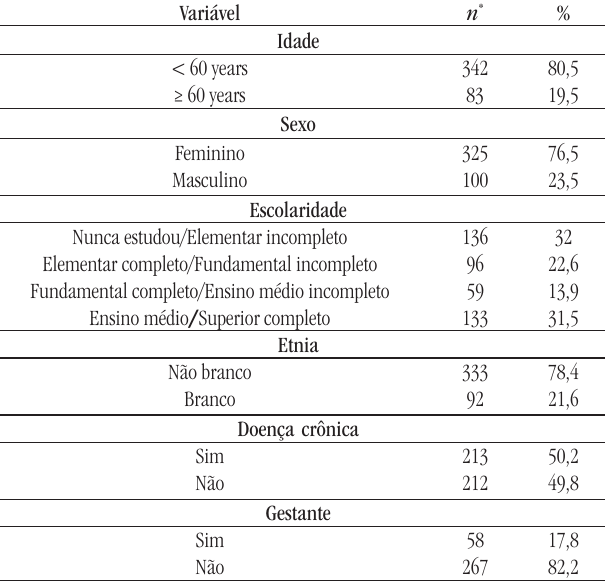
LACEM: Laboratório Central Municipal; * o n pode variar entre as categorias devido a perdas amostrais.. tabela 3 – Variáveis pré-analíticas relacionadas com interferências em exames